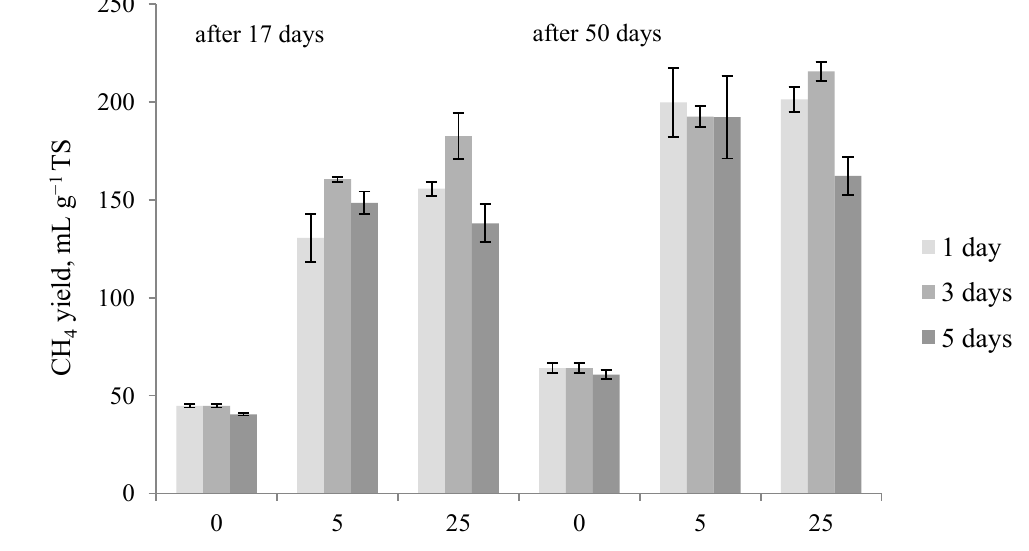
Figure 2. Methane yield after 17 and 50 days of anaerobic digestion of non-treated and AAS-treated digested swine manure fibers with 5% and 25% reagent concentrations in